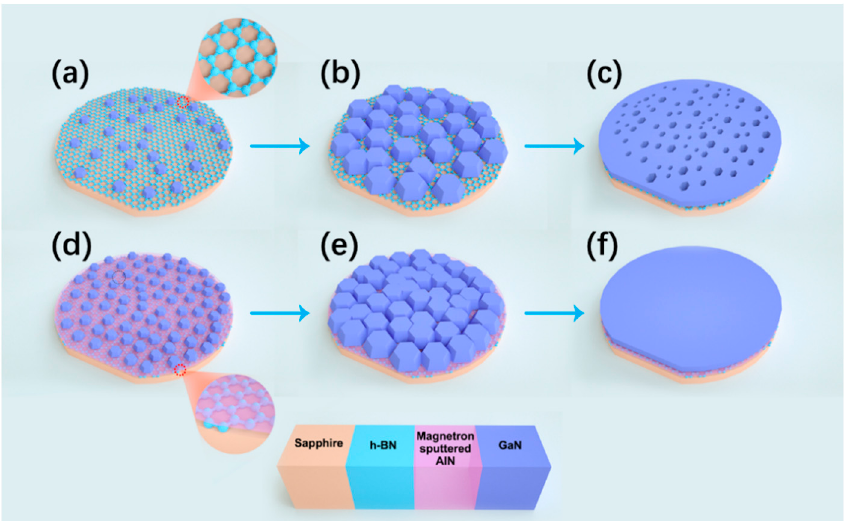
Figure 8. The epitaxial mechanism of GaN on h-BN/sapphire substrate and sputtered AlN/h-BN/sapphire substrate: ( a ) GaN nucleation process, ( b ) formation of GaN islands and ( c ) GaN film on h-BN/sapphire substrate; ( d ) GaN nucleation process, ( e ) formation of GaN islands and ( f ) GaN film on sputtered AlN/h-BN/sapphire substrate.